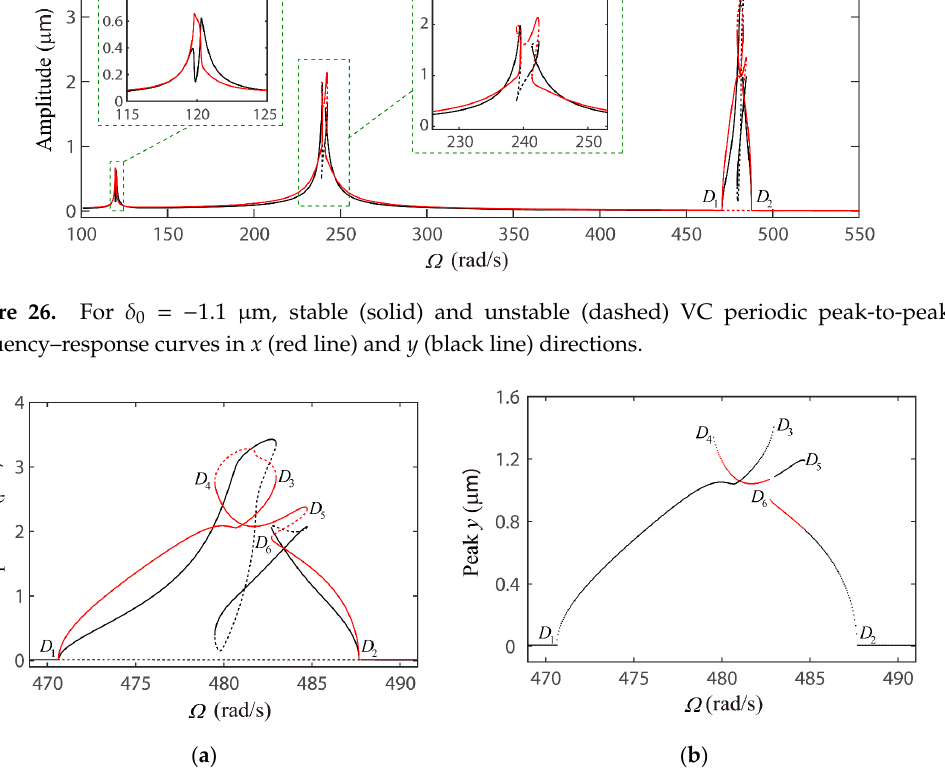
Figure 27. For δ 0 = − 1.1 μ m, the response characteristics in 1/2-order subharmonic resonance, ( a ) the frequency–response curves in x (red line) and y (black line) directions, and ( b ) numerical bifurcation diagrams of local maxima of y ( τ ) when Ω sweeps up (black dots) and down (red dots).